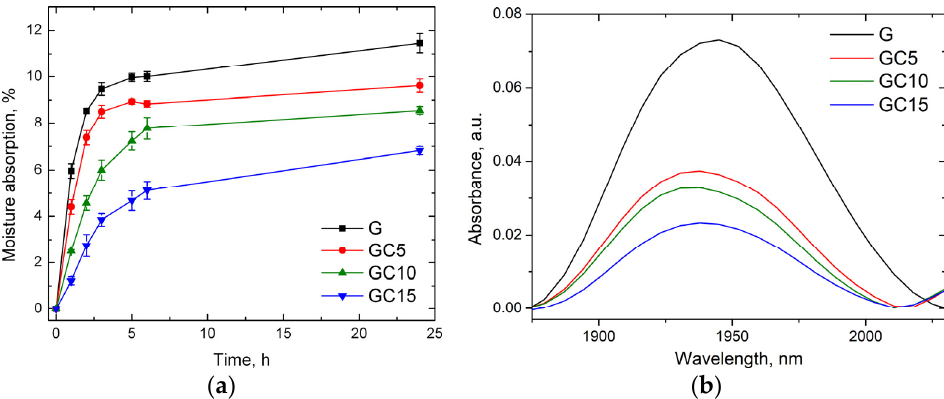
Figure 7. Moisture adsorption after exposing the gelatin and composite films at 57% for 24 h ( a ) and the NIR band from 1940 nm at 57% RH after 24 h of exposure ( b ).